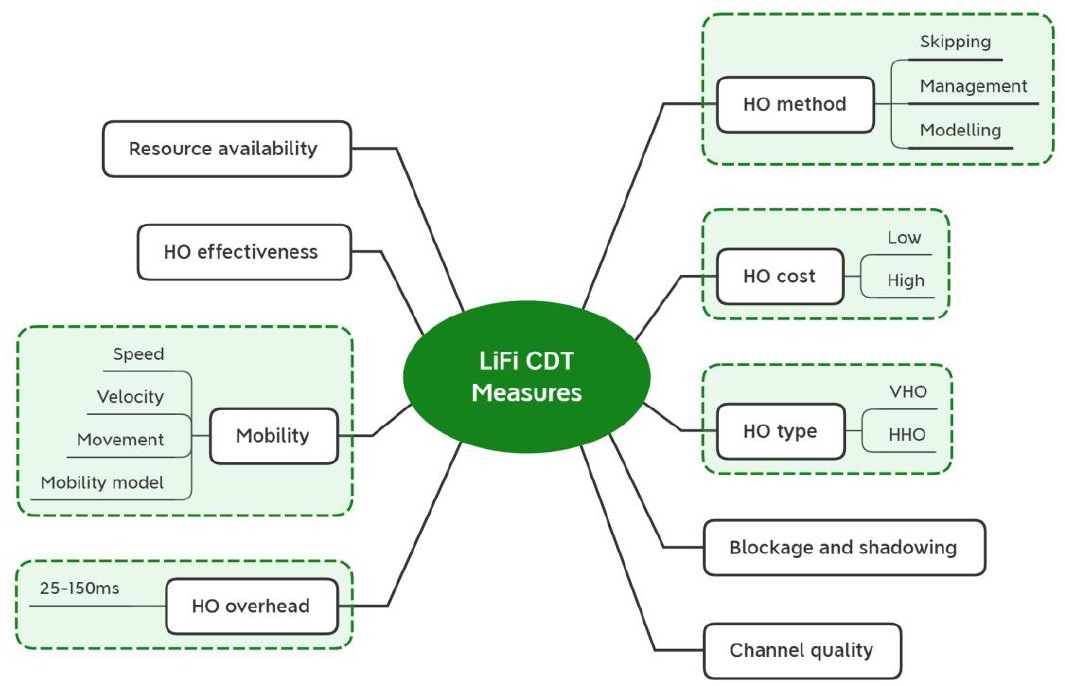
Figure 6. Factors involved in measurements of LiFi CDT.